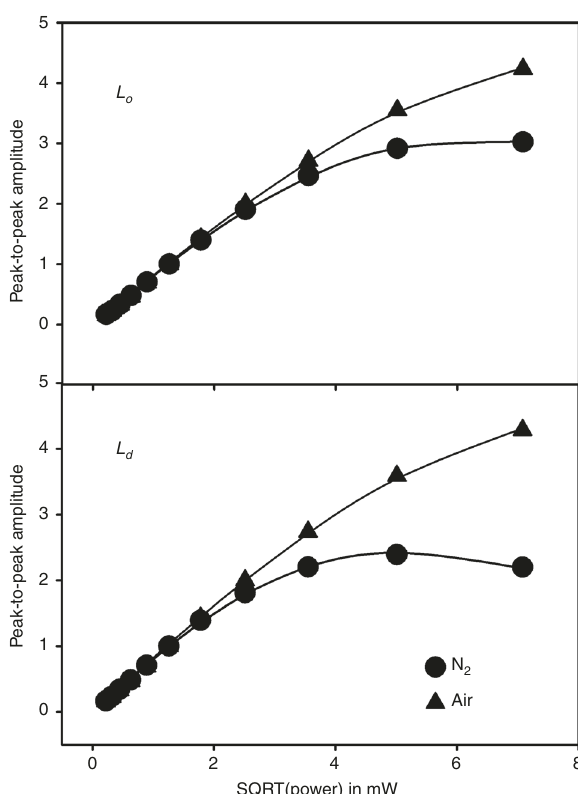
Fig. 7 Power-saturation curves of 16:0 – 16 Doxyl PC in L o and L d phases. Membranes were exposed to N 2 (circles) and air (21% O 2 , triangles). The peak-to-peak amplitude of the M I = 0 resonance (center peak in Fig. 6) was measured as a function of microwave power from 50 to 0.05 mW. The line is a fi t to the experimental data as described by Eq. (8). Source data are provided as a Source Data fi le.